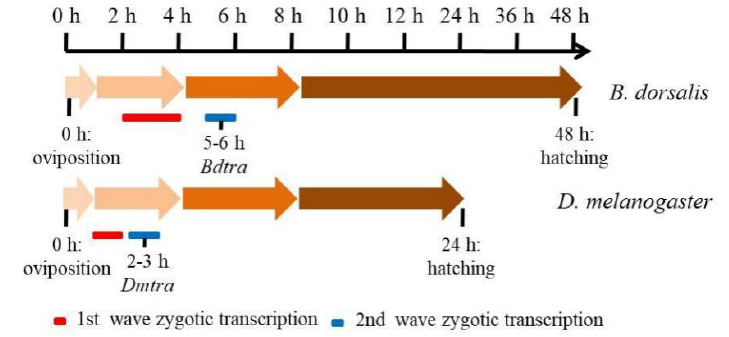
indicate statistically significant differences ( p < 0.05) among the three stages based on Student’s t-test.